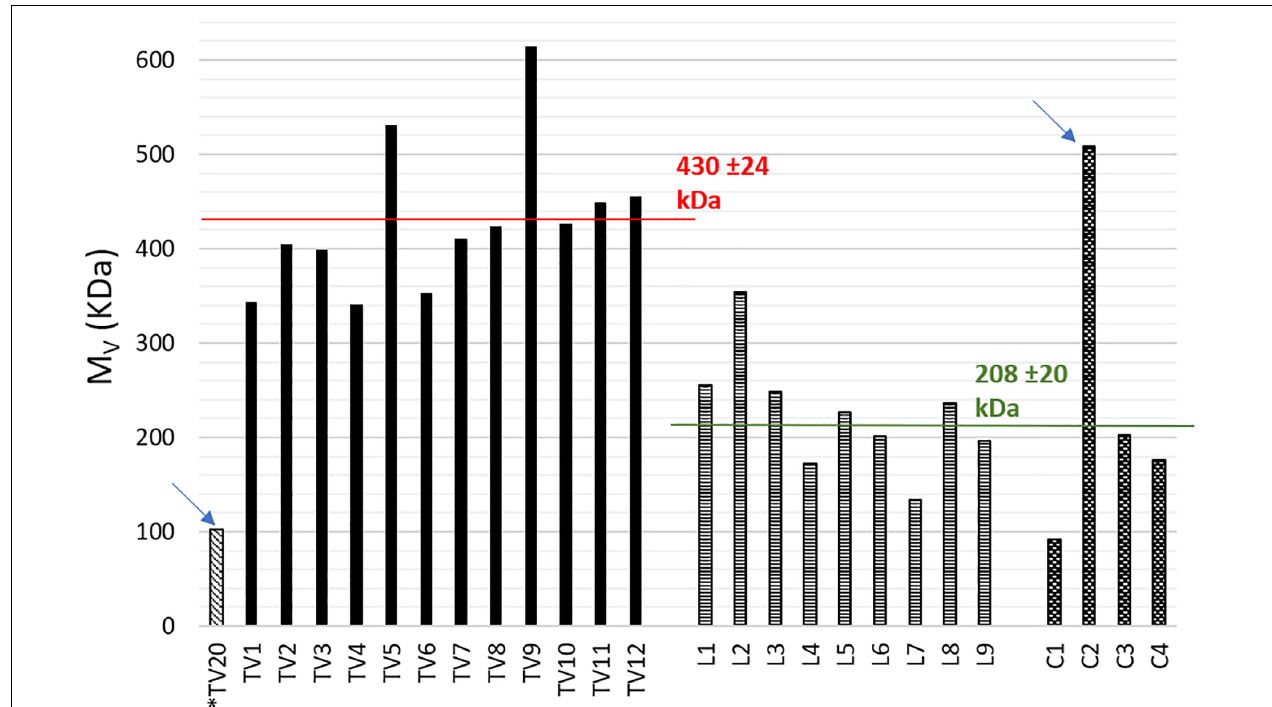
FIGURE 3 | Comparison of viscosity average molecular weights ( M v ). Starred sample TV20 is thermal